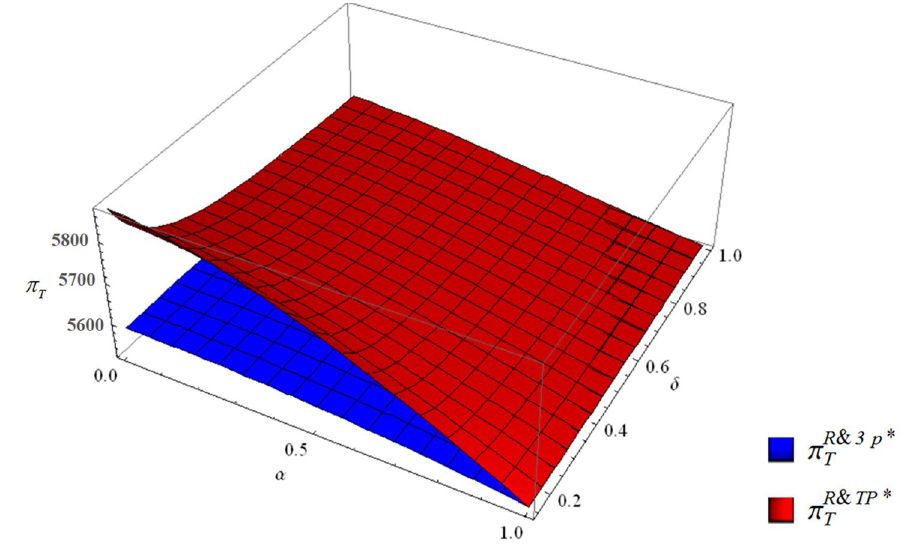
Figure 8. The total profits with or without third-party economies of